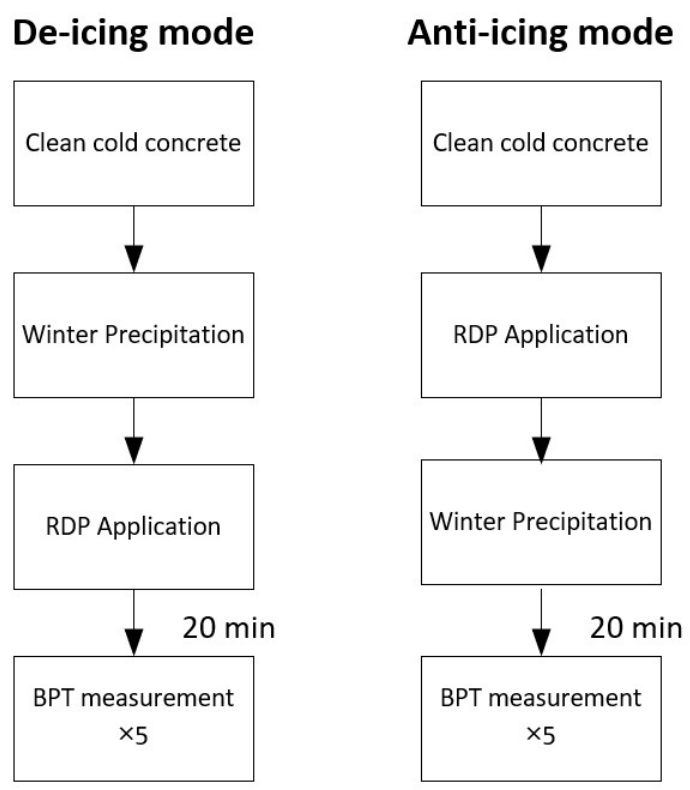
Figure 4. De-icing and anti-icing protocols.